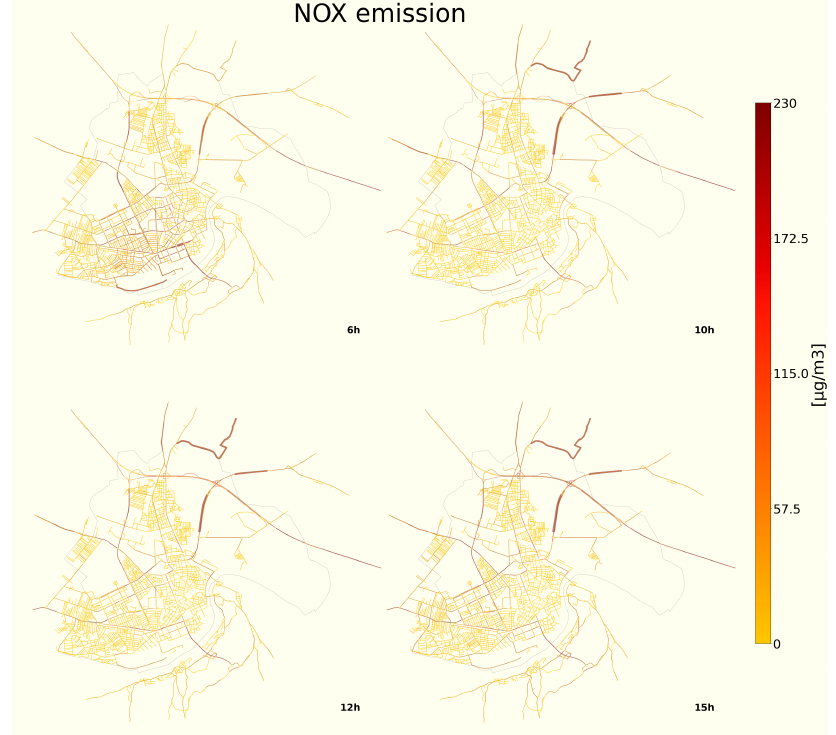
Figure A5. NO x emission intensity at different hours.